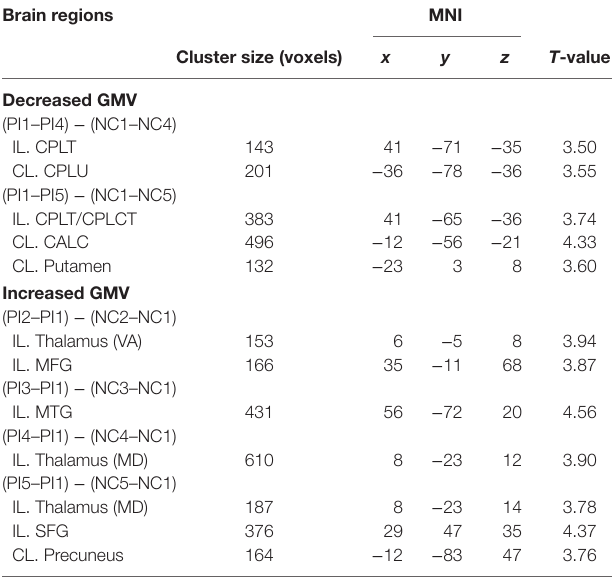
TaBle 2 | Whole-brain GMV changes in PI group compared with NC group. Brain